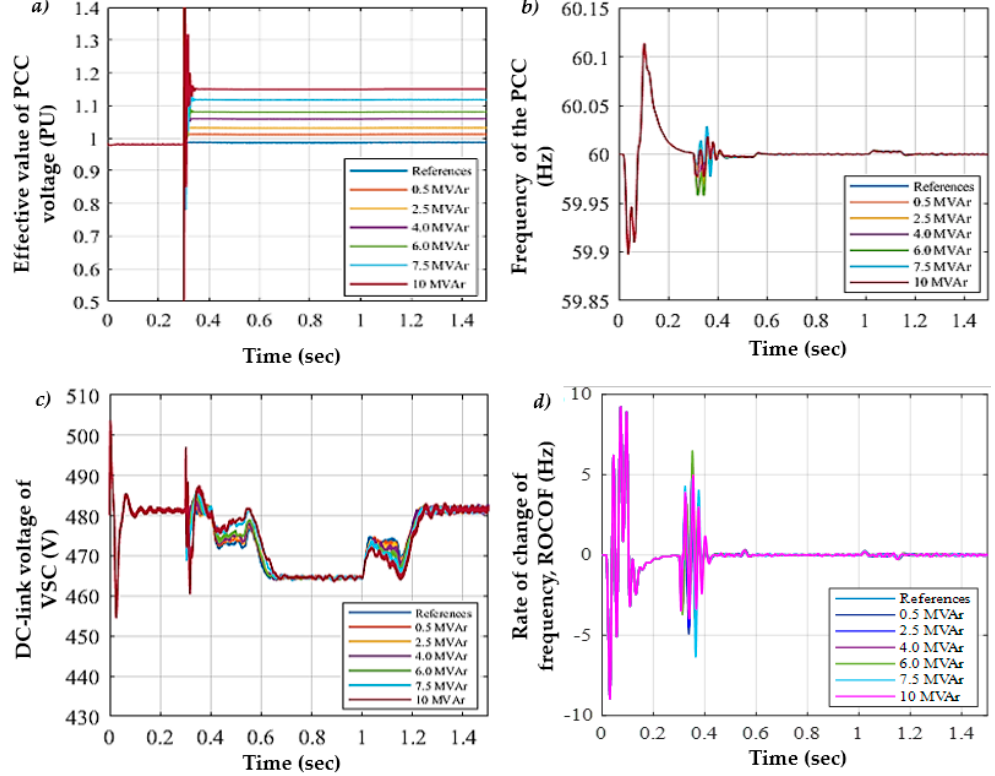
Figure 12. Simulation case of capacitive switching, ( a ) the effective value of PCC voltage; ( b ) variation of the frequency at the point of common coupling; ( c ) the dc-link voltage of voltage source control; ( d ) rate of change of frequency in capacitor bank switching for non-islanding.